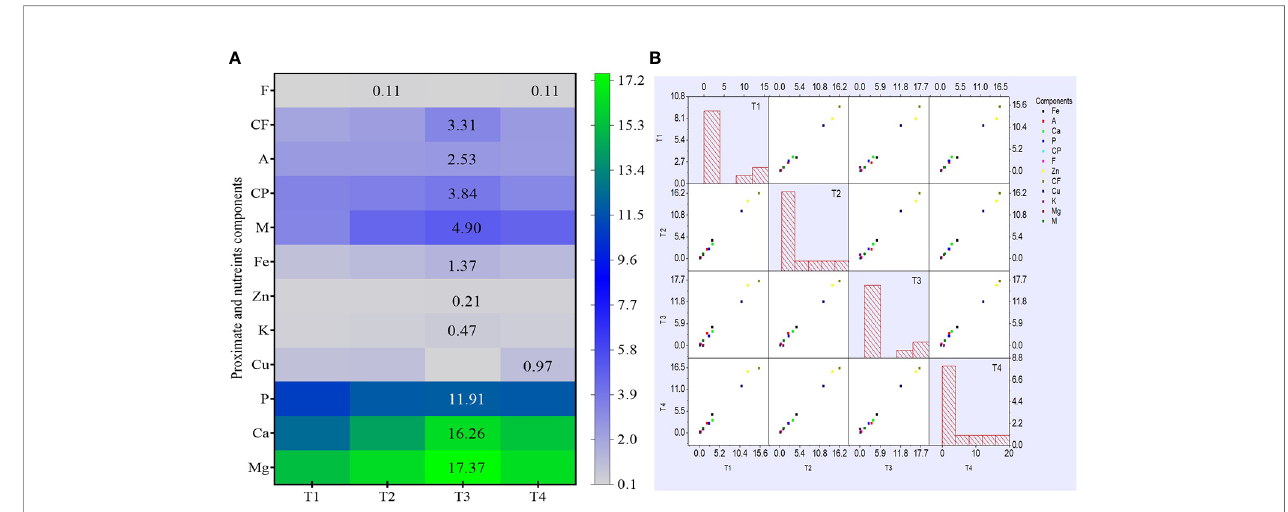
FIGURE 4 | (A) Heat map analysis of proximate and nutrient constituents. (B) A Scatter Matrix plot with histogram demonstrating pair-wise scatter plots of variables in a matrix format, determining variables correlation. Where, M: Moisture; CP: Crude protein; CF: Crude fi ber; A: Ash; F: Fat; K: Potassium; Ca: Calcium; Mg: Magnesium; P: Phosphorus; Zn: Zinc; Fe: Iron; Cu: Copper; T1: Untreated control; T2: seeds + CDK15; T3: seeds + CDK25; T4: seeds + Consortium (CDK15 + CDK25). Values are expressed as mean ± SD (n = 6); Level of signi fi cance: p <